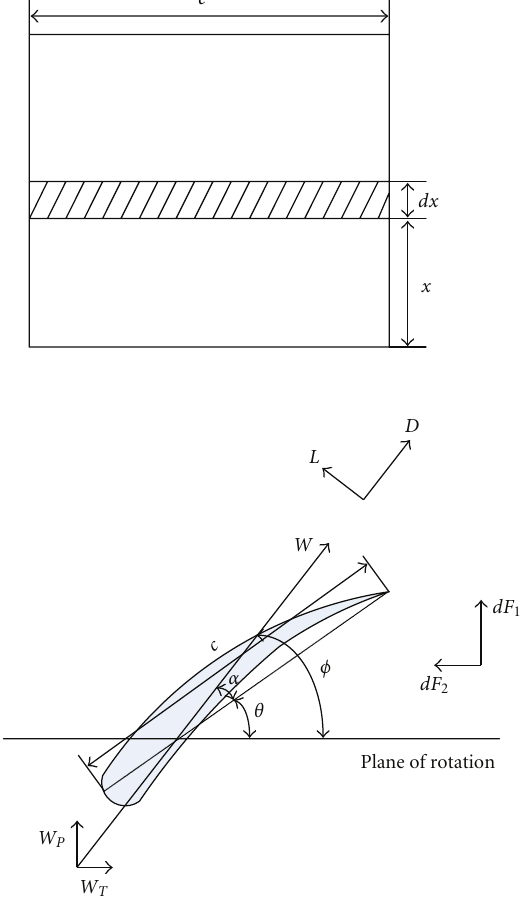
Figure 2: Airfoil for one blade element. α : angle of attack; φ : angle between the relative wind and the plane of rotation; θ : pitch angle; L : lift force normal to the wind direction; D : profile drag parallel to the wind direction; d F 1 : thrust force on the blade element normal to the plane of rotation; d F 2 : drag force onthe blade element tangential to the circle swept by the rotor; W : relative wind speed; W P : component of W normal to the plane of rotation; W T : component of W tangential to the circle swept by the rotor; c : chord length; x : radial location of a blade